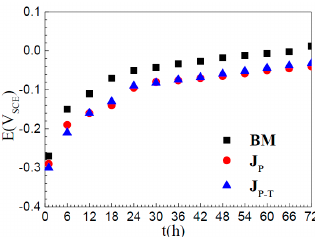
Figure 3. Open circuit potential curves measured in 1 M NaCl solution at room temperature.